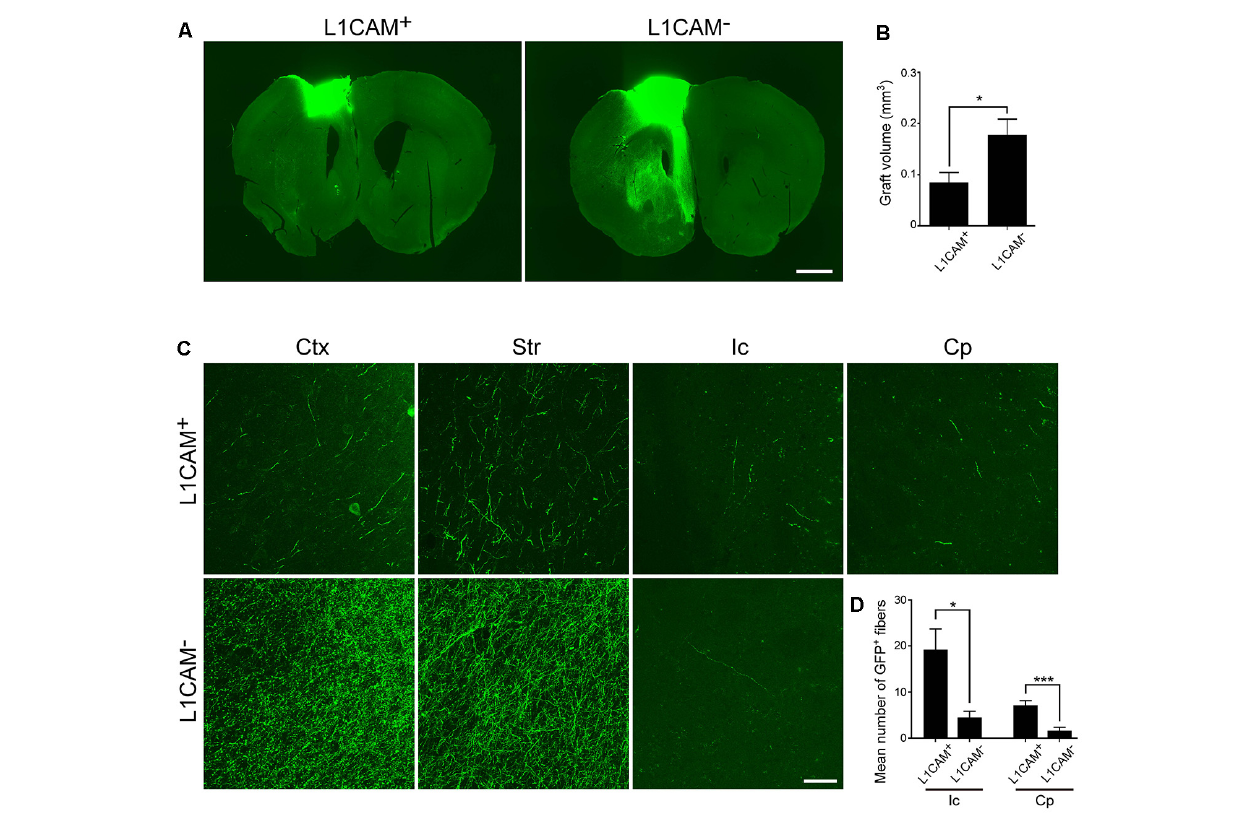
FIGURE 5 | L1CAM + cells survive and extend axons along the corticospinal tract (CST). L1CAM + cells and L1CAM − cells were isolated from E14.5 mouse frontal cortex, and 2 days later they were injected into the adult brain for 2 months. (A) Immunofluorescence images of the graft for GFP (green). Scale bar represents 1 mm. (B) Quantification of the volume of L1CAM + cells and L1CAM − cells in the grafts (L1CAM + : n = 6 and L1CAM − : n = 6). (C) Immunofluorescence images of the graft fibers for GFP (green). GFP + fibers were found in the cerebral cortex (Ctx), striatum (Str), internal capsule (Ic) and cerebral peduncle (Cp). Scale bar represents 50 µ m. (D) Quantification of GFP + fibers from L1CAM + cells and L1CAM − cells (L1CAM+: n = 6 and L1CAM − : n = 6) at the Ic and Cp. All values are displayed as means ± SEM. Student’s t -test, * P < 0.05 and *** P <